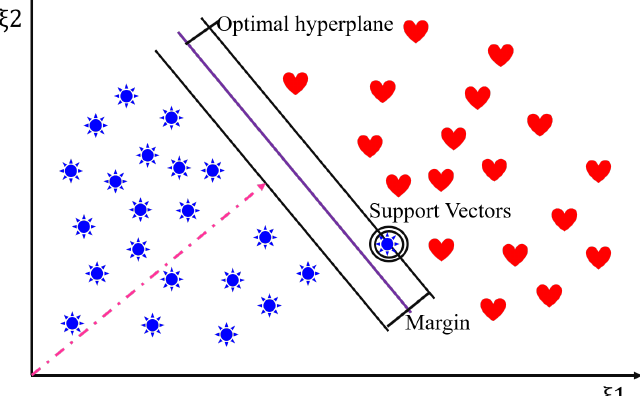
Figure 7. Demonstration of